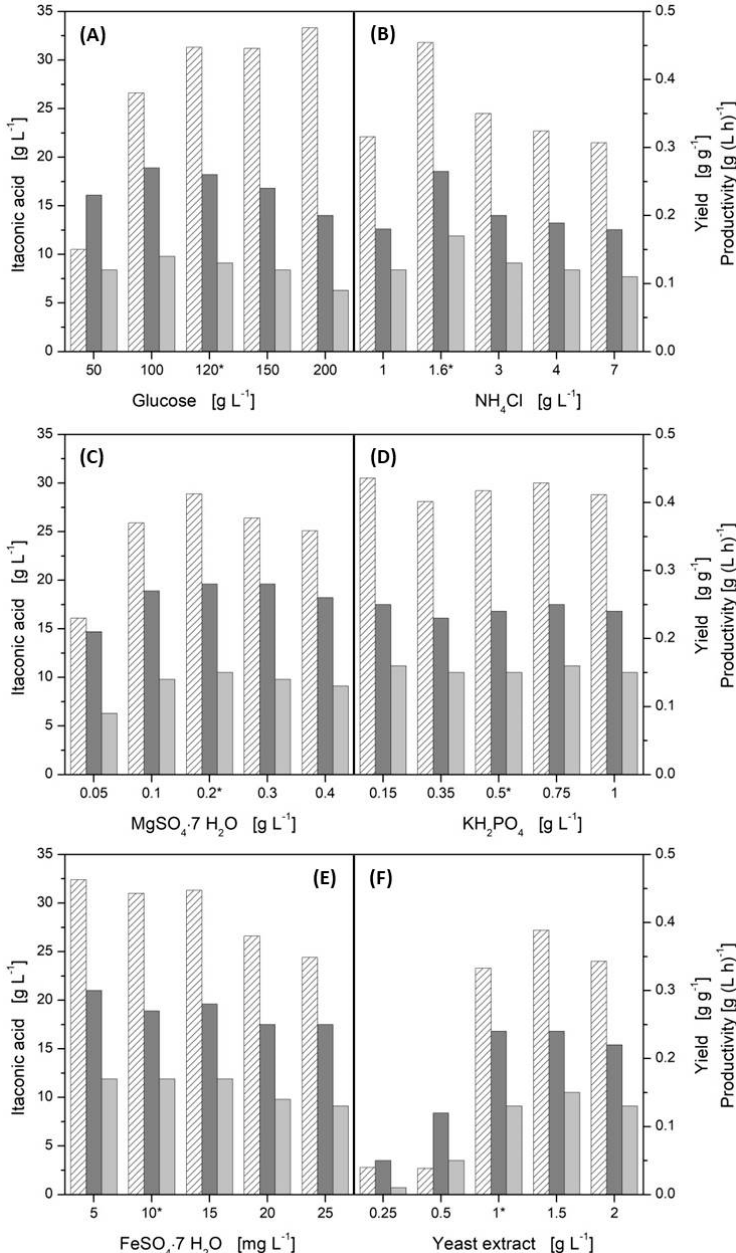
Figure 2. Influence of Tabuchi-medium components in 250 mL shake flasks on the final titer (dashed bar), yield (black bar), and productivity (grey bar) of U. rabenhorstiana at 120 rpm and 30 °C after 7.8 days ( B – F ). Cultivation time for different initial glucose concentrations depended on the point of glucose limitation ( A ). Asterisks highlight the standard media composition.